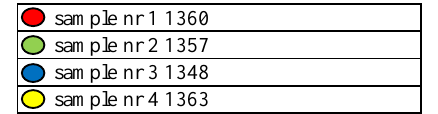
Table 2. Results of the thermoluminescence dating of brick samples from the western outer wall of the Justice Court Tower.